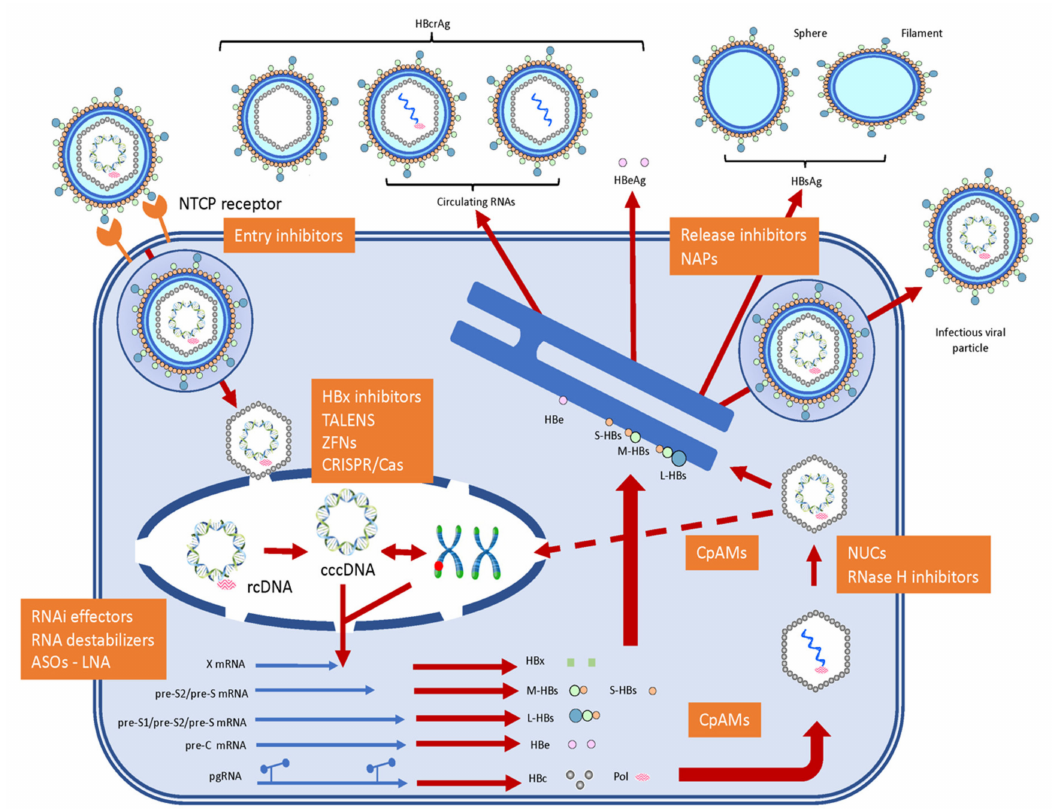
Figure 2. Schematic diagram of HBV infection pathway. The pathway of infection involves NTCP receptor-mediated uptake of HBV particles into hepatocytes, followed by controlled endo-osmolysis that enables the nuclear capsid to enter the cell nucleus where rcDNA can be processed into fully functional cccDNA. This is either propagated into pgRNA for new virus particle production or integrated into host cell chromosomes. The pgRNA has multiple functions to initiate the re-synthesis of viral DNA, plus originate pre-C mRNA and all other sub viral mRNAs that code for all the main viral proteins. In the case of the first function, pgRNA is encapsulated with viral DNA polymerase (Pol) using HBc proteins to form immature nucleocapsids within which pgRNA is subject to reverse transcription by Pol to form complementary single-stranded DNA [negative (anti-sense)]. This is then nicked during reverse transcription as positive (sense) strand DNA is being partially generated and rcDNA reformed. Packaged rcDNA in mature nucleocapsid is then processed through the endoplasmic reticulum (ER) of a host hepatocyte leading to exocytosis of mature infectious HBV viral particles. The di ff erent classes of active pharmaceutical agents (APIs) that can modulate the infection cycle are as follows: entry inhibitors that act on NTCP mediated entry; anti-cccDNA agents such as HBx inhibitors, transcription activator-like e ff ector nucleases (TALENs), zinc finger nucleases (ZFNs), and clustered regularly interspaced short palindromic repeat (CRISPR) / CRISPR-associated endonuclease (Cas); anti-mRNA agents such as RNA interference (RNAi) e ff ectors, RNA destabilizers, and antisense oligonucleotides (ASOs)–locked nucleic acids (LNAs); anti-nucleocapsid assembly agents such as core protein allosteric modulators (CpAMs); reverse transcriptase inhibitors such as nucleoside / nucleotide analogues (NUCs) or RNaseH inhibitors; release inhibitors including nucleic acid polymers